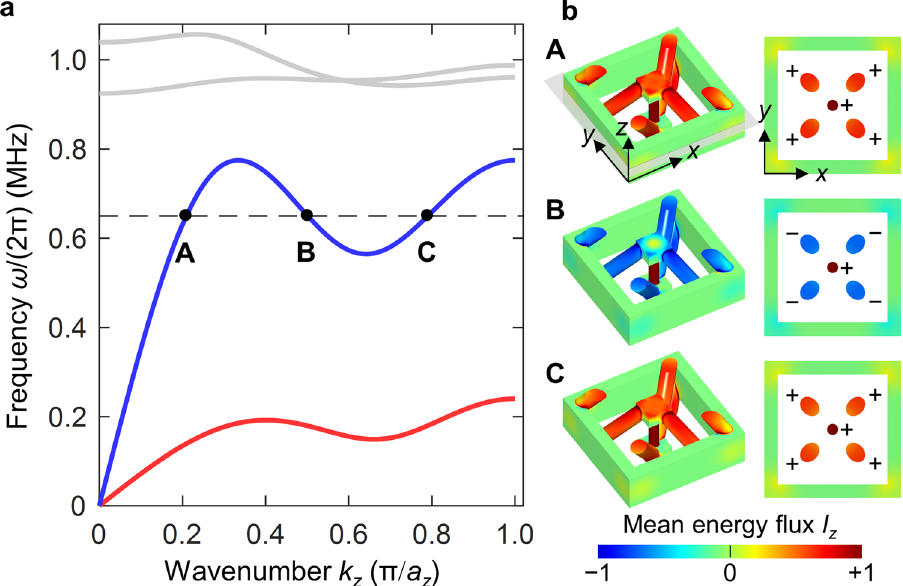
(cid:3) (cid:4) Þ of the architecture in Fig. 3 is shown for ¼ ω ð(cid:2) k z ¼ 100 μ m (cf. Fig. 3), aspect z